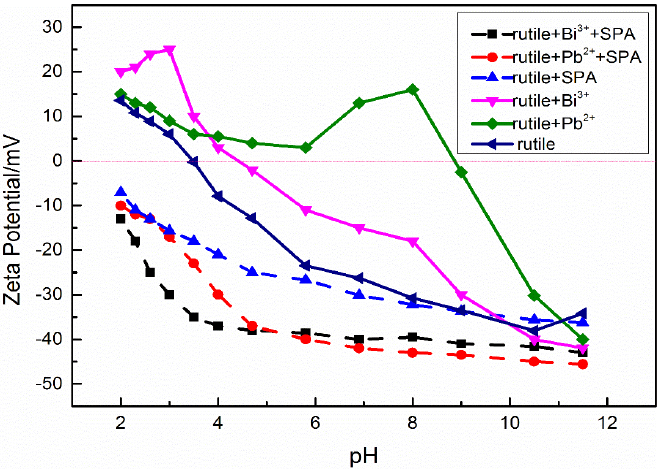
Figure 7. Zeta potential of rutile surface with a function of pH.